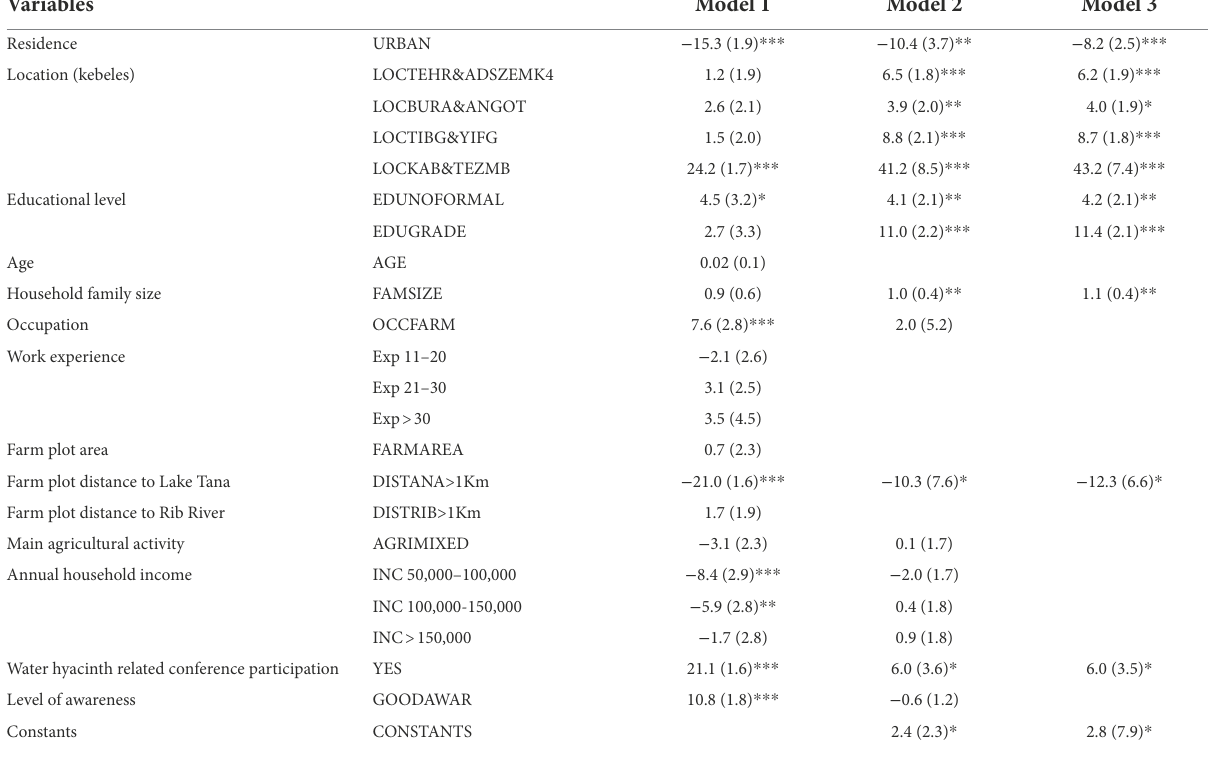
TABLE 2 Interval regression results of WTCL for improving Lake Tana ecosystem services ( n =